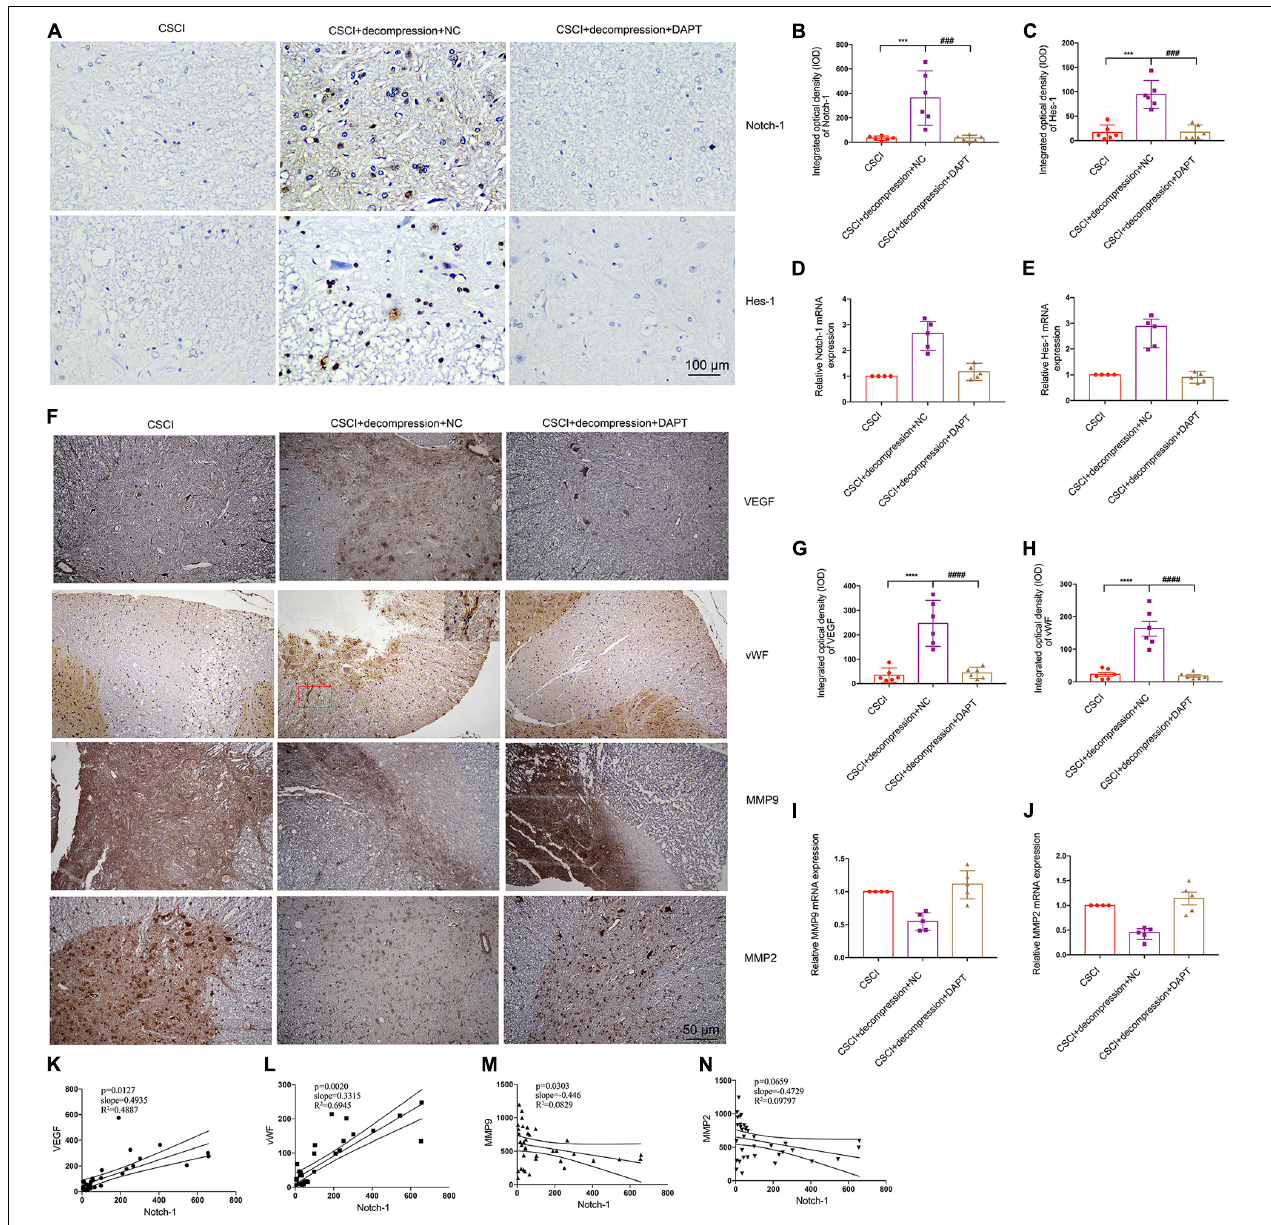
FIGURE 8 | Inhibition of Notch-1 resulted in decreased VEGF, vWF, MMP-9, and MMP-2 expression. (A) Notch-1 and Hes-1 expression levels were assessed by IHC (400 × magnification; scale bar, 100 µ m). IHC staining of (B) Notch-1 [One-way ANOVA, F (2,15) = 14.12, p < 0.001; Tukey post hoc : *** p < 0.001, ### p < 0.001] and (C) Hes-1 was quantitated by analyzing the IOD [One-way ANOVA, F (2,15) = 30.64, p < 0.001; Tukey post hoc : *** p < 0.001, ### p < 0.001]. Relative expression levels of (D) Notch-1 and (E) Hes-1 were assessed by RT-qPCR. (F) VEGF, vWF, MMP-9, and MMP-2 expression levels were assessed by IHC (200 × magnification; scale bar, 50 µ m). IHC staining of (G) VEGF [One-way ANOVA, F (2,15) = 27.56, p < 0.0001; Tukey post hoc : **** p < 0.0001, #### p < 0.0001], and (H) vWF [One-way ANOVA, F (2,15) = 34.93, p < 0.0001; Tukey post hoc : **** p < 0.0001, #### p < 0.0001] was quantitated by analyzing the IOD.